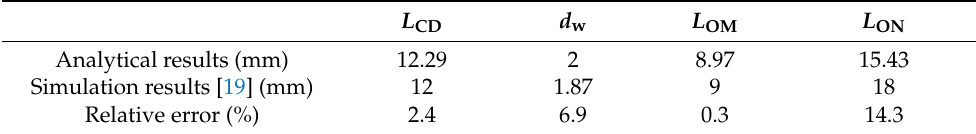
Table 4. Comparison of analytical and numerical